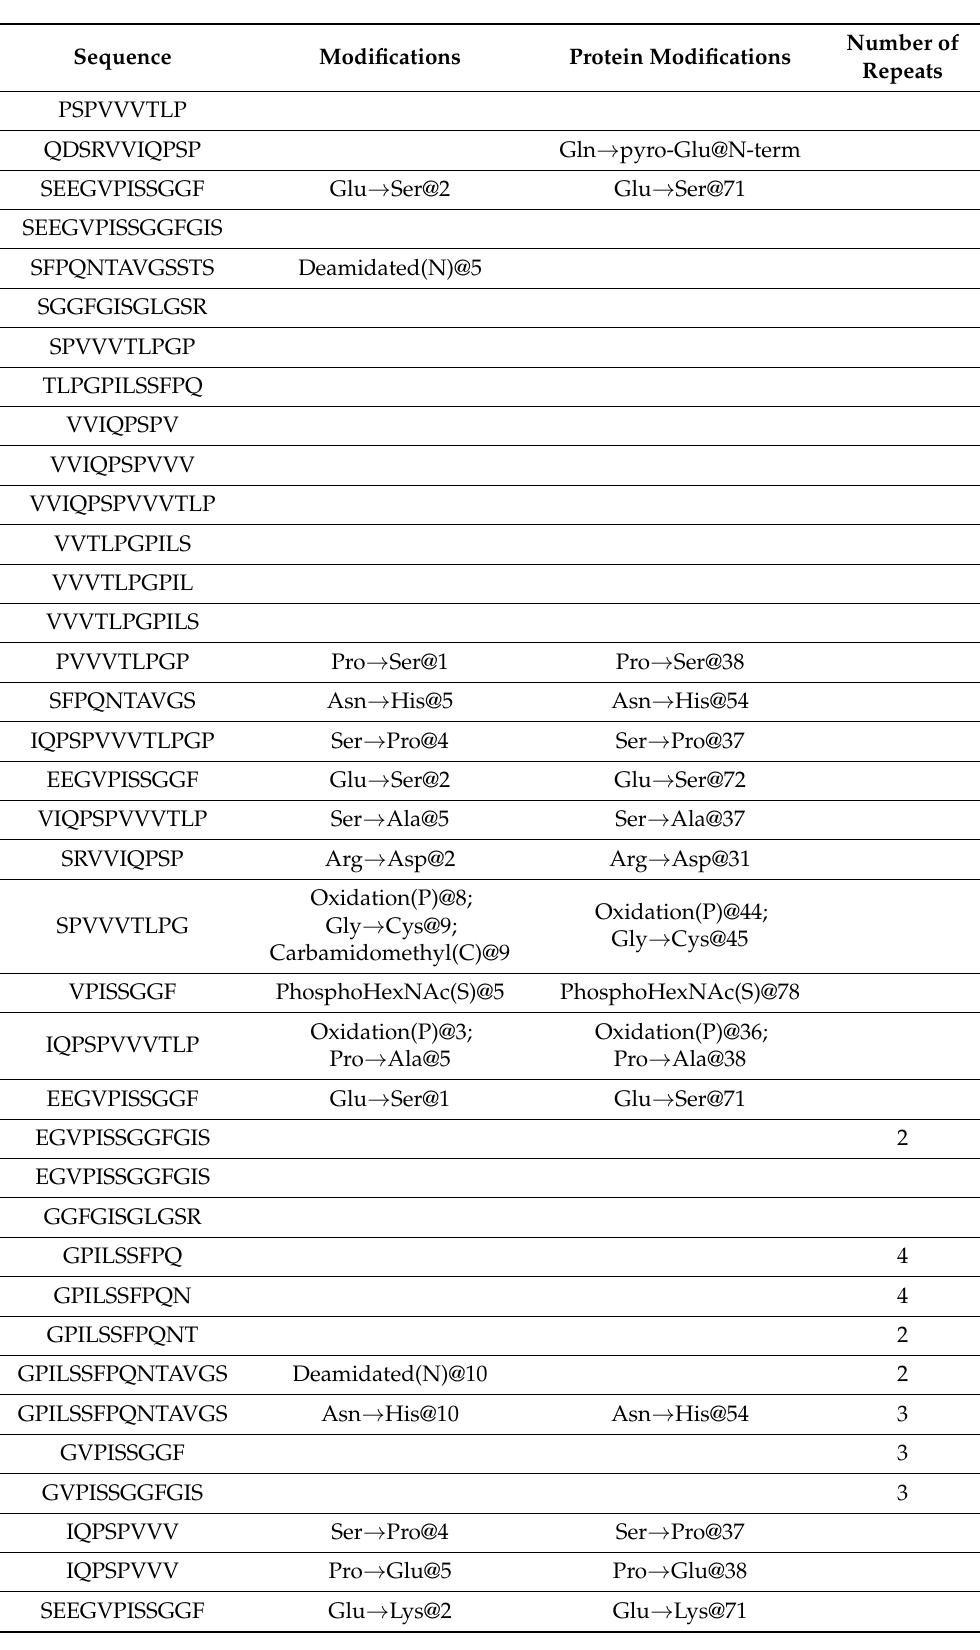
Number of Repeats